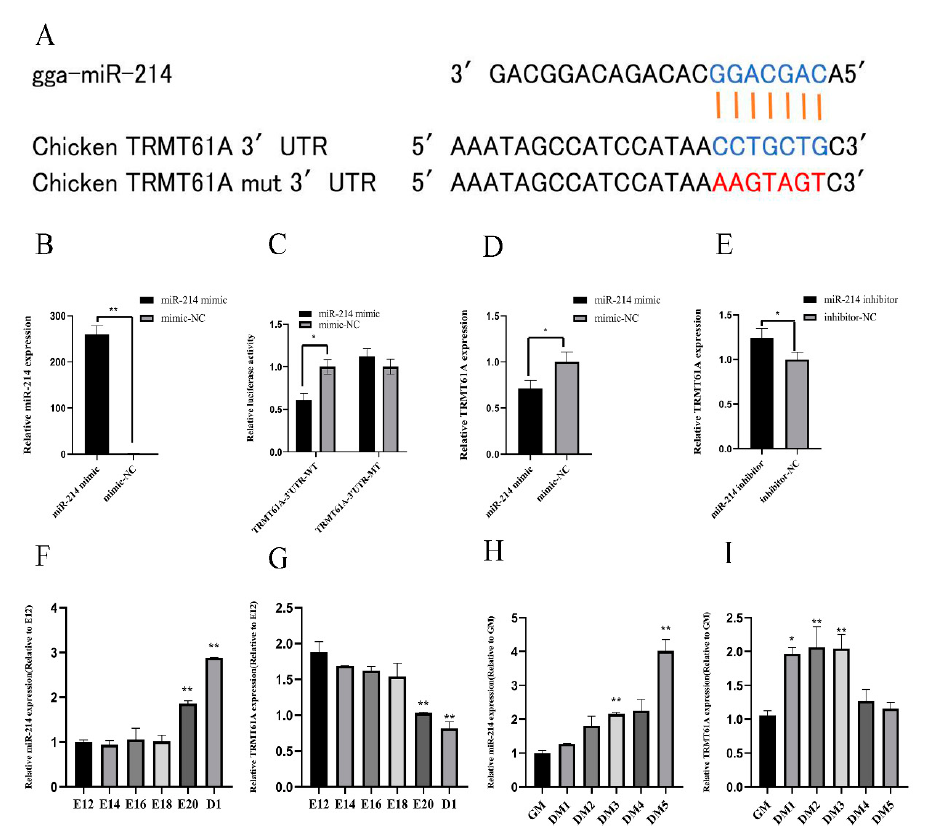
Figure 3. miR-214 targets TRMT61A and negatively regulates TRMT61A. ( A ) The potential binding site of miR-214 in the TRMT61A mRNA 3 ′ UTR. The mutation sequence for the miR-214 binding site is shown in red. ( B ) The relative expression of miR-214 after transfection of the miR-214 mimic into 293T cells. ( C ) A luciferase assay was conducted by co-transfecting wild-type or mutant TRMT61A 3 ′ UTR with the miR-214 mimic or the mimic NC in 293T cells. ( D , E ) The expression level of TRMT61A in the CPMs after miR-214 overexpression and interference. ( F , G ) The expression pattern of miR-214 and TRMT61A in the leg muscle in the embryonic period and at one day old. ( H , I ) The expression patterns of miR-214 and TRMT61A during the period of proliferation and differentiation. * p < 0.05 and ** p < 0.01.